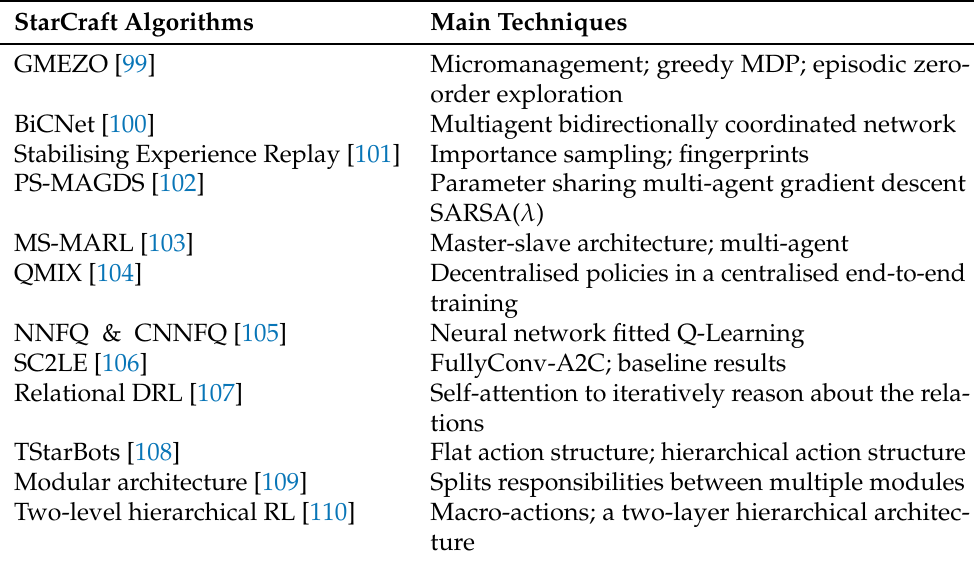
Table 3. Techniques used in StarCraft, summarized based on